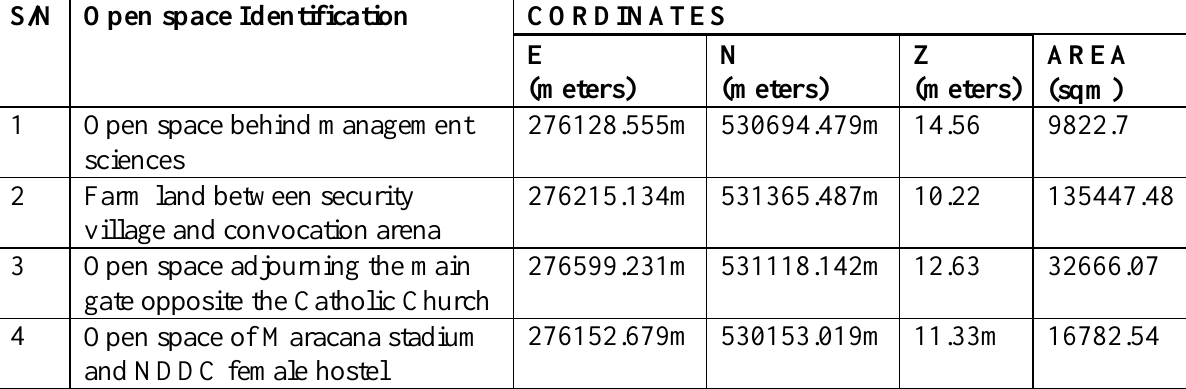
Table 3: Location and sizes of Open Spaces in Zone (C)